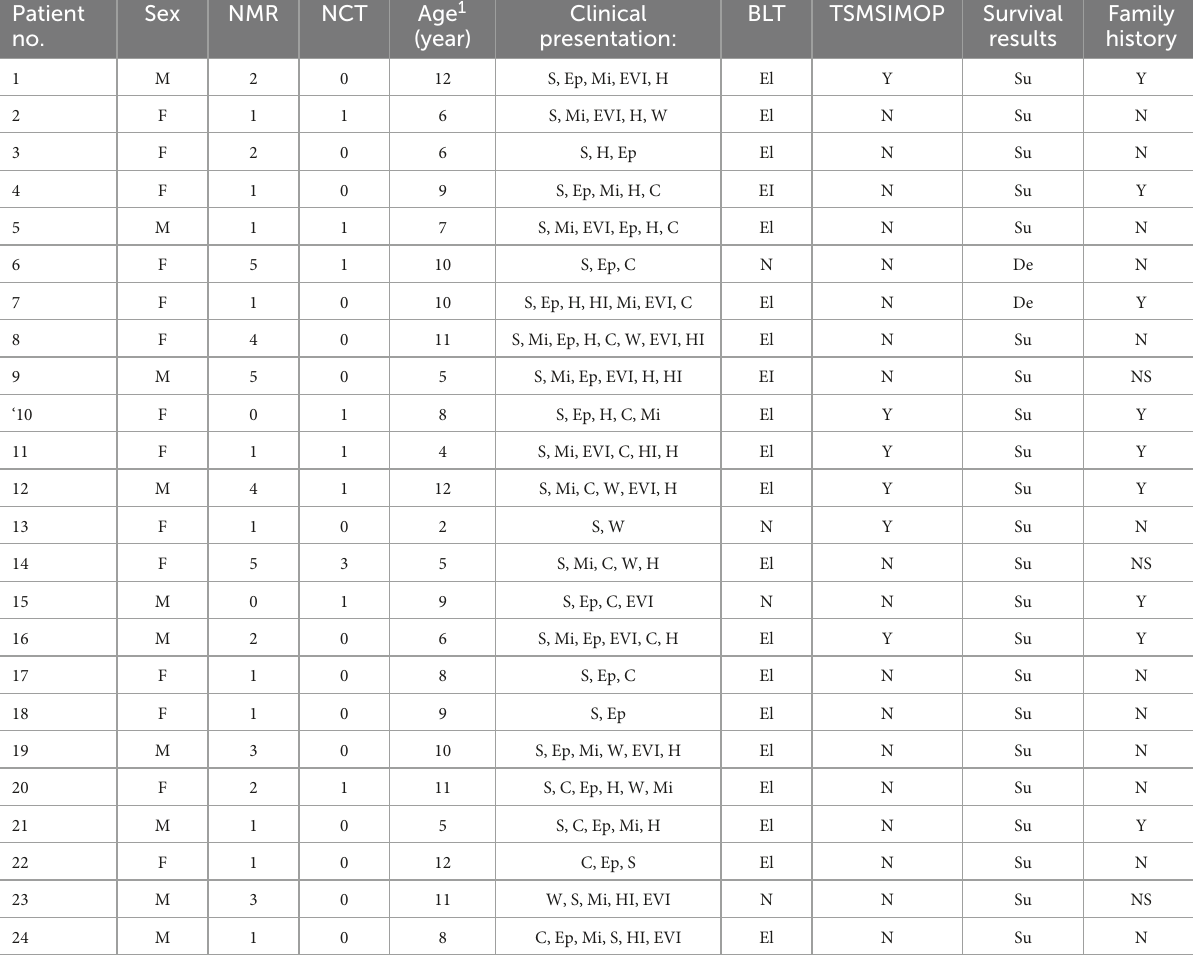
TABLE 1 Genetic factors, laboratory results, and clinical presentation. Patient